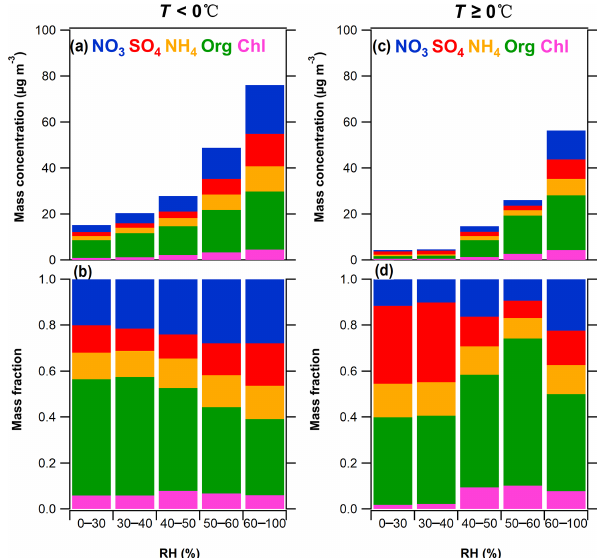
Figure 10. Mass concentration and mass fractions of aerosol species dependence on RH at different temperature ranges. Panel (a) and (b) denote the situation for − 14 ◦ C < T < 0 ◦ C. Panels (c) and (d) denote the situation for 0 ◦ C < T < 8 ◦